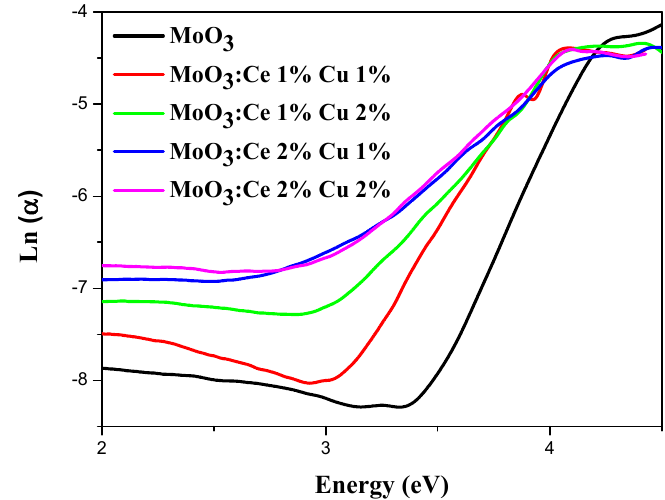
Figure 4. Ln α vs. h ν spectra of MoO 3 :Ce–Cu sprayed thin films.